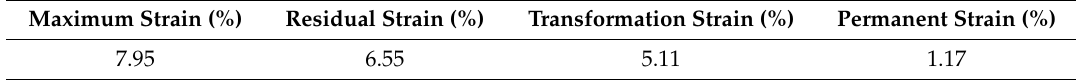
Table 1. Various strain readings of the sample tested in Figure 2.